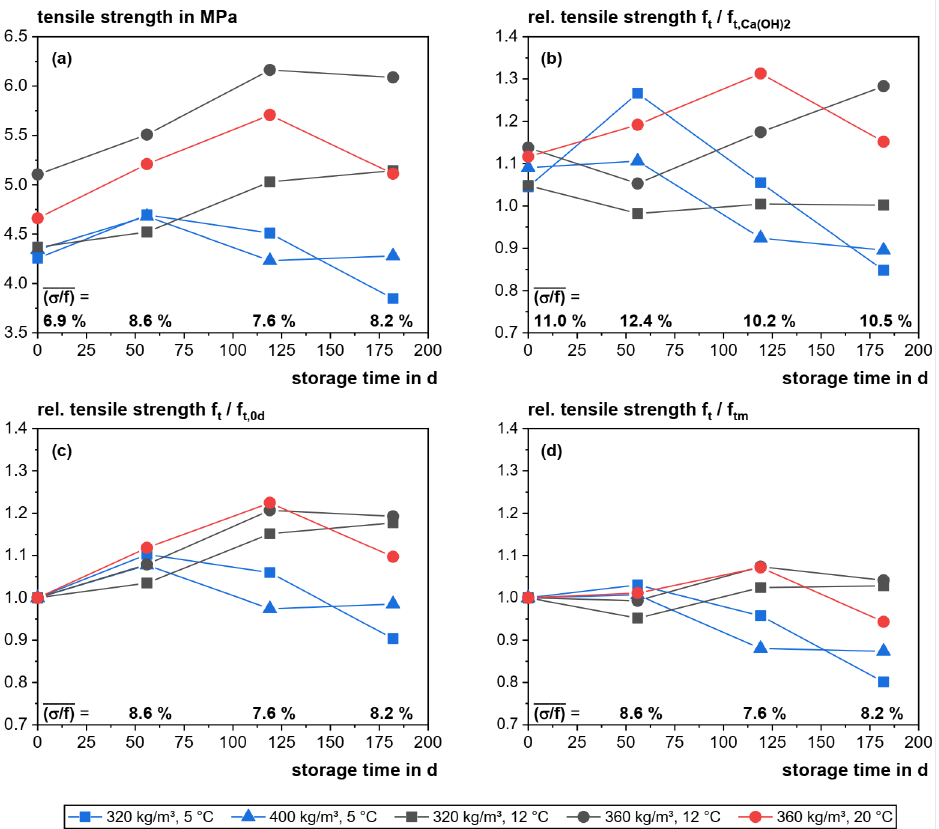
Figure 2. Exemplary results of concrete with CEM I 42.5 N and w/c = 0.45 stored in Na 2 SO 4 solution at 6000 mg SO 42 − /L, ( a ) tensile strength, ( b ) relative tensile strength with Ca(OH) 2 -storage as a reference, ( c ) relative tensile strength with 28 d strength as a reference (called f t,0d for 0 d of sulfate storage) and ( d ) relative tensile strength with the reference strength calculated with the maturity